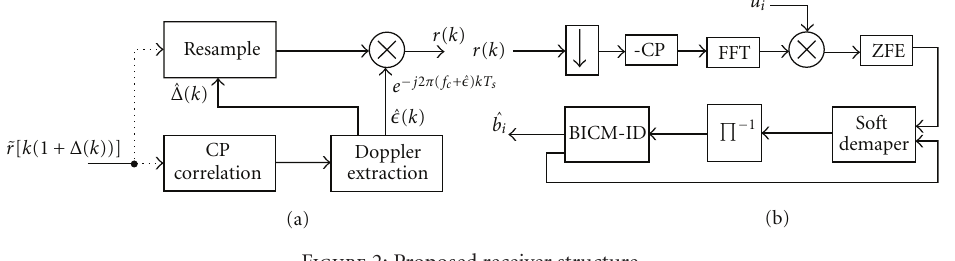
Figure 2: Proposed receiver